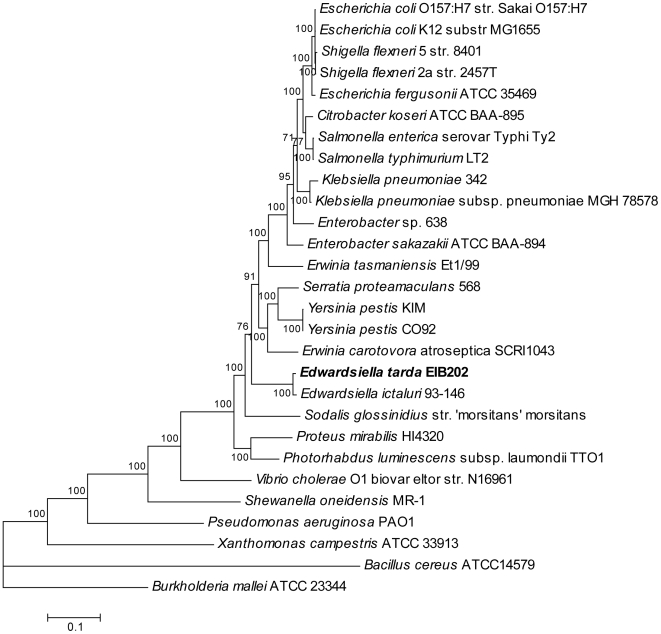
Phylogenetic relationship of EIB202.Phylogenies of Enterobacteriaceae species inferred from concatenated alignments of the protein sequences encoded by 44 housekeeping genes as described in the Materials and Methods. Bacillus cereus ATCC 14579 was used as the outgroup. Accession numbers for the selected bacterial genome sequences are as following: Bacillus cereus ATCC 14579, NC_004722; Burkholderia mallei ATCC 23344, NC_006348; Citrobacter koseri ATCC BAA-895, NC_009792; E. ictaluri 93-146, NC_012779; E. sakazakii ATCC BAA-894, NC_009778; Enterobacter sp. 638, NC_009436; E. carotovora atrosepticum SCRI1043, NC_004547; E. tasmaniensis Et1/99, NC_010694; E. coli K-12 substr MG1655, NC_000913; E. coli O157:H7 str. Sakai O157:H7, NC_002695; E. fergusonii ATCC 35469, NC_011740; K. pneumoniae 342, NC_011283; K. pneumoniae subsp. pneumoniae MGH 78578, NC_009648; P. luminescens subsp. laumondii TTO1, NC_005126; Proteus mirabilis HI4320, NC_010554; Pseudomonas aeruginosa PAO1, NC_002516; S. enterica subsp. enterica serovar Typhi str. Ty2, NC_004631; S. typhimurium LT2, NC_003197; S. proteamaculans 568, NC_009832; Shewanella oneidensis MR-1, NC_004347; S. flexneri 2a str. 2457T, NC_004741; S. flexneri 5 str. 8401, NC_008258; Sodalis glossinidius str. morsitans, NC_007712; Vibrio cholera O1 biovar eltor str. N16961, NC_002505; Wigglesworthia brevipalpis endosymbiont of Glossina brevipalpis, NC_004344; Xanthomonas campestris pv. campestris str. ATCC 33913, NC_003902; Y. pestis CO92, NC_003143 ; and Y. pestis KIM, NC_004088.